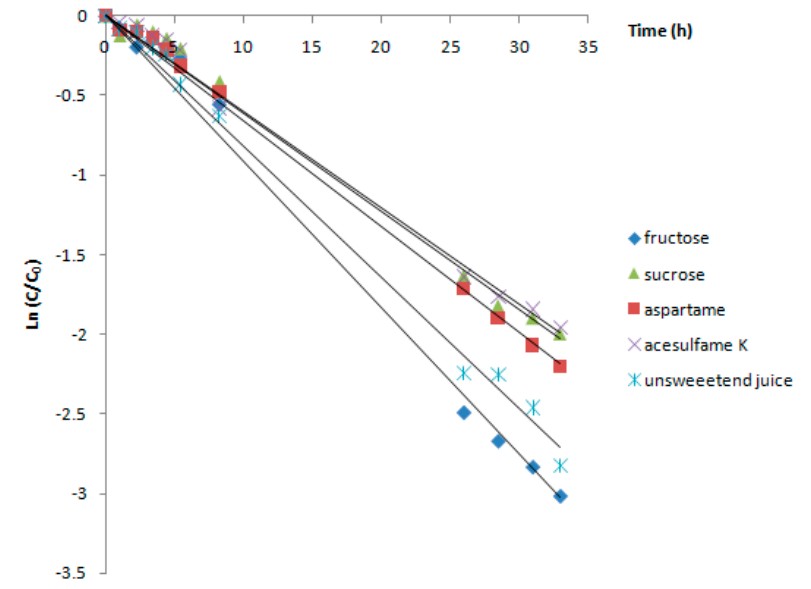
Figure 4. Degradation of the anthocyanins from Cornelian cherry fruit juice at 75 °C.